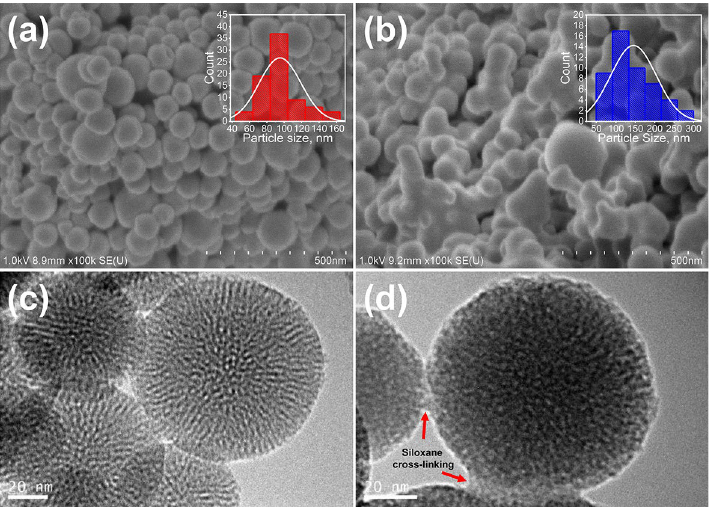
Figure 3. SEM images of ( a ) MSN and ( b ) MSN-AmEA, the inserted box with red and blue graph color indicate the particle size distribution of nanoparticles. TEM images of ( c ) MSN and ( b ) MSN-AmEA. The siloxane network of organosilane compounds linked to the spherical MSN is observed by TEM.